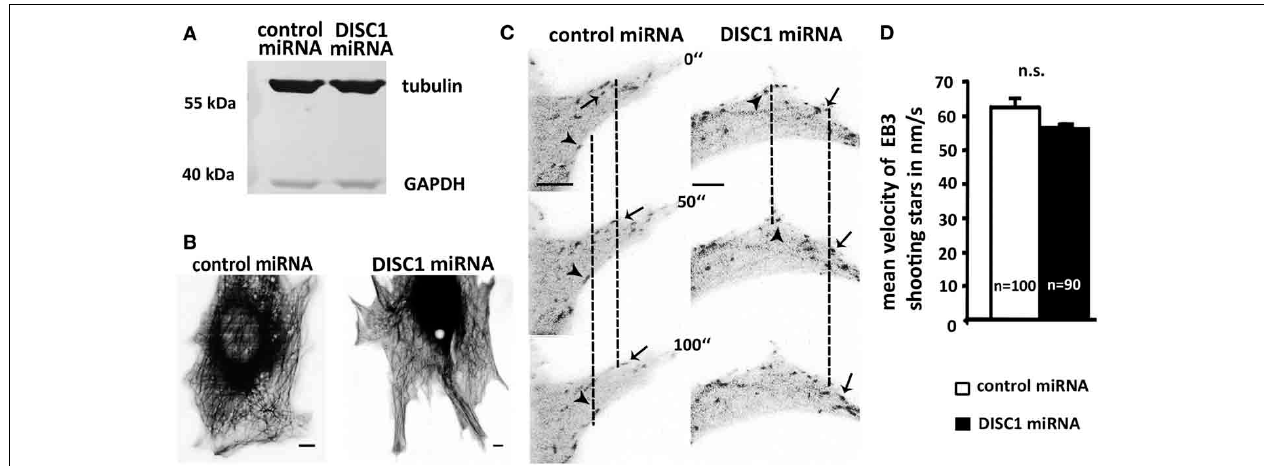
FIGURE 7 | DISC1 deficient cells exhibit neither alterations in microtubule polymerization nor integrity. (A) Western blot analysis of control miRNA and DISC1 miRNA expressing fibroblasts revealed no change in the tubulin level after DISC1 knockdown. (B) Inverted fluorescent micrographs of NIH3T3 fibroblasts expressing control or DISC1 miRNA as well as Tubulin-GFP. Scale bar: 5 μ m. (C) Time line of